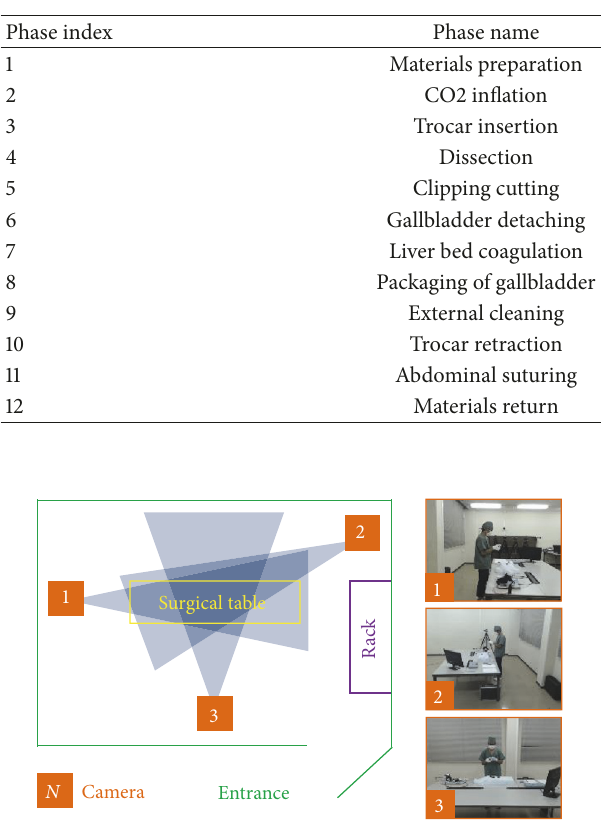
Table 5: The 12 phases of the cholecystectomy surgical workflow.